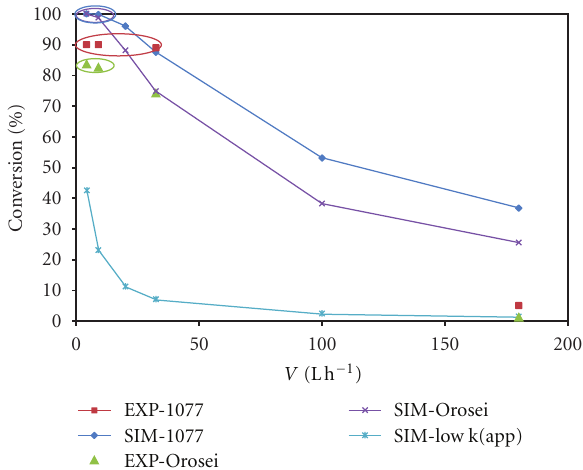
Figure 6: Experimental (EXP) and simulated (SIM) percentage conversion in dependence on the flow rate, as reported in Table 1 relevant to the two samples considered in the flowing condition experiments (1077 and Orosei active) or the relevant simulated apparent kinetic constants (4 × 10 − 3 and 2.3 × 10 − 3 ms − 1 , respectively. The light blue curve corresponds to the simulated data adopting a lower apparent kinetic constant, 1 × 10 − 4 ms − 1 .